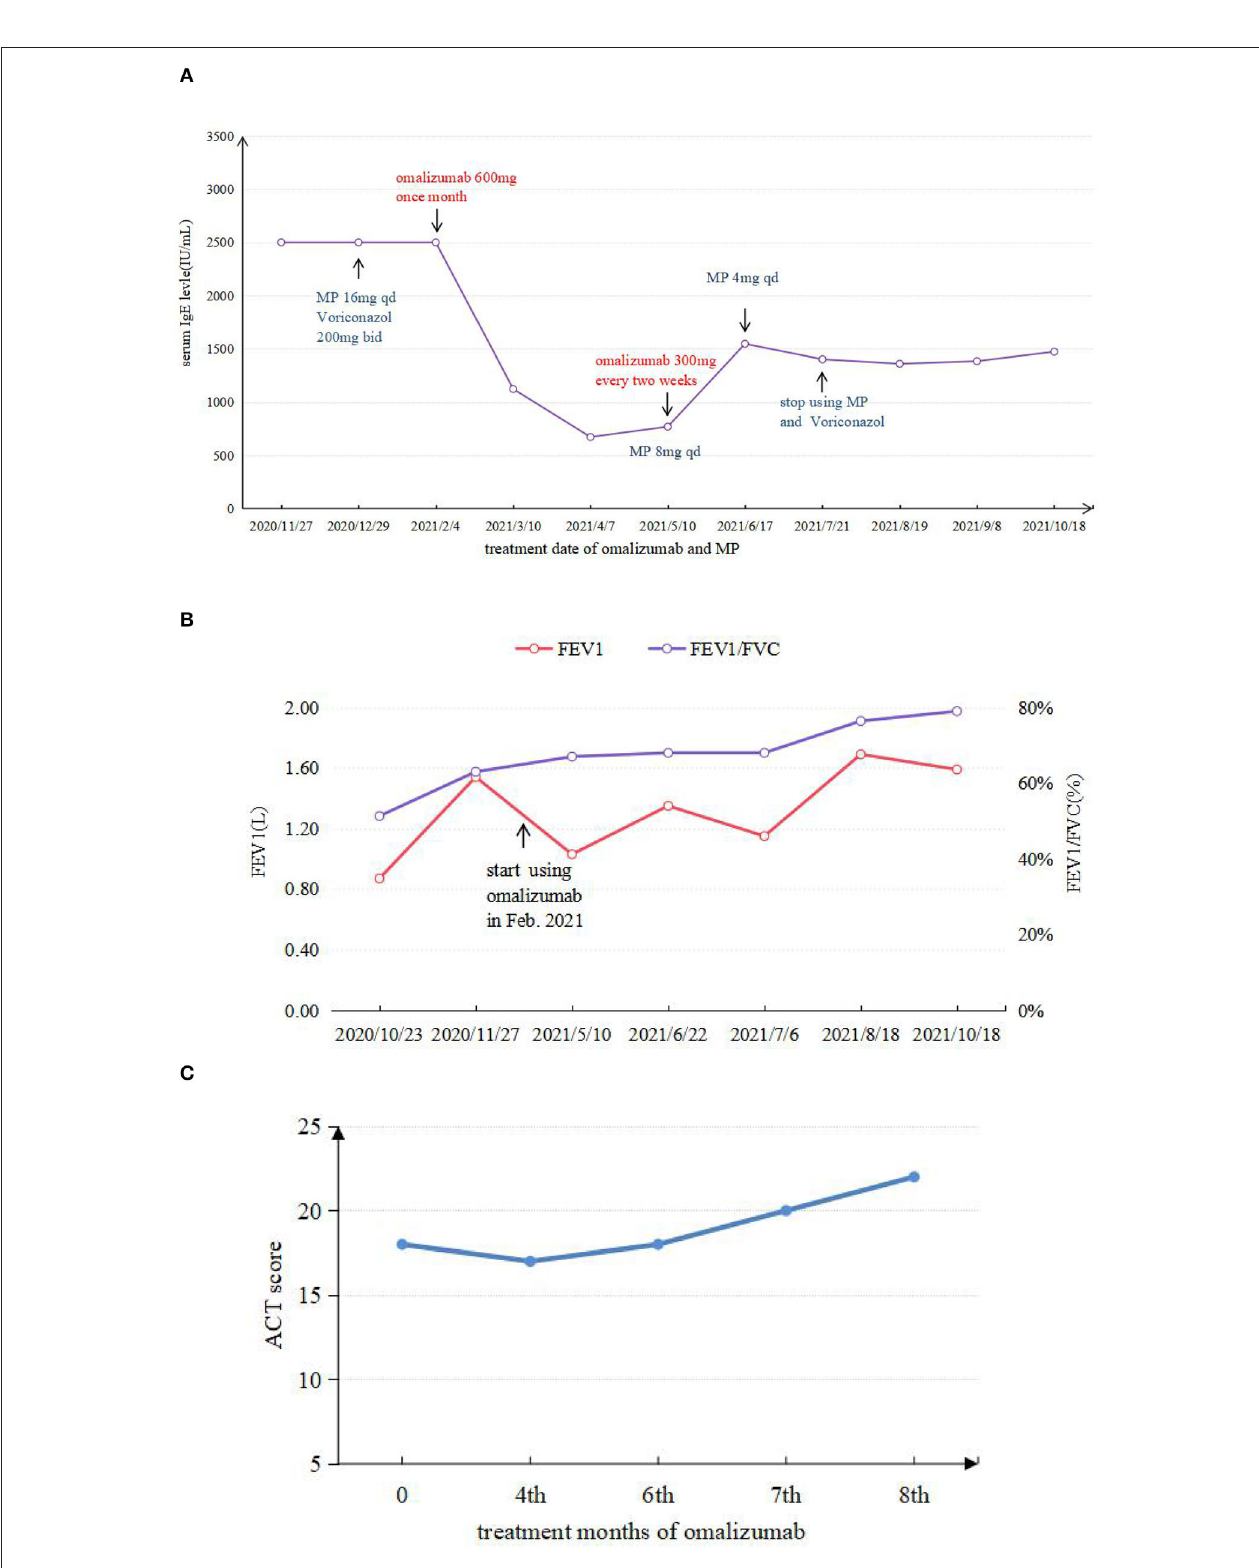
FIGURE 3 | (A) Comparison between IgE levels during application of omalizumab and MP. (B) FEV1 and FEV1/FVC test results in different periods. (C) ACT score results in different periods.